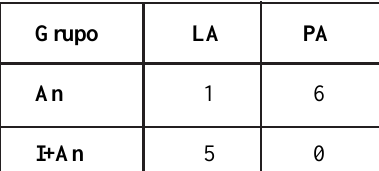
TABELA 3 – Local de ruptura da parede colônica.